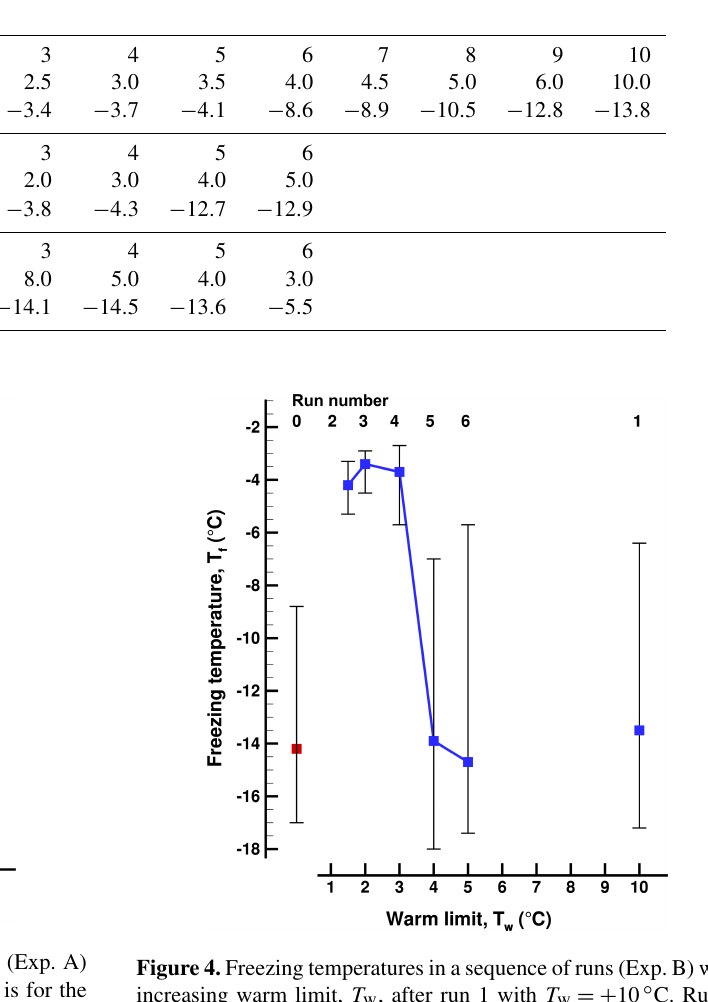
Table 1. Average freezing temperatures, T f ( ◦ C), observed in the three series of experiments with gradually increasing and gradually de- creasing warm limits, T w ( ◦ C).